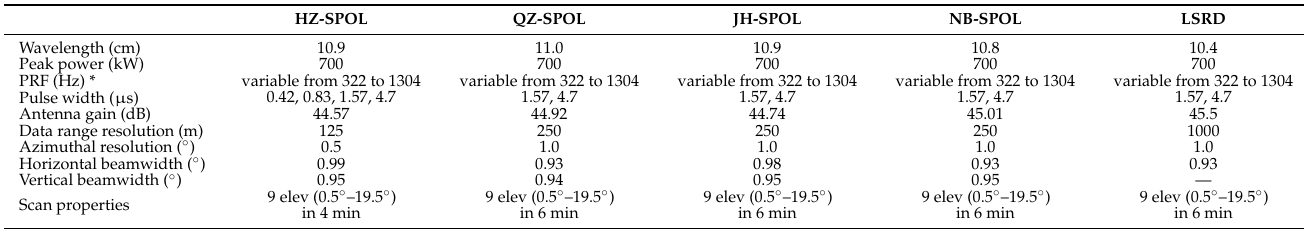
Table 1. Radar characteristics (PRF is pulse repetition